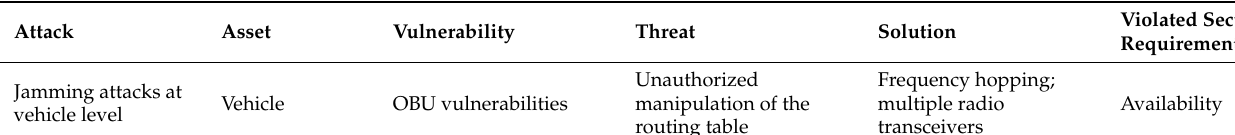
Table 2. Attacks targeting